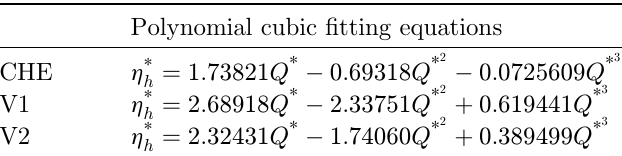
Table 1. The hydraulic ef fi ciency ( h discharge ( Q *) for each